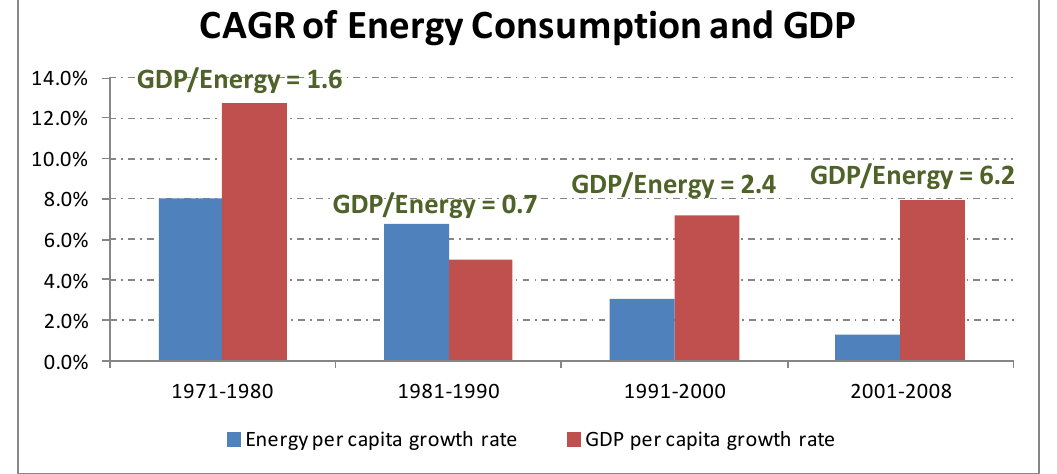
Figure 7. The Compound Annual Growth Rate (CAGR) of energy per capita and GDP per capita for Malaysia between the years of 1971 and 2008 are presented above. The growth rate in energy consumption per capita is less than the growth rate in per capita GDP for all the different eras except for the period between 1981 and 1990 when the world was faced with several crises. The GDP to Energy ratio signifies the percent annual GDP growth rate per capita for every 1% growth in per capita energy consumption. Data for energy consumption and GDP were obtained from [24,58], respectively. The chart was plotted by the